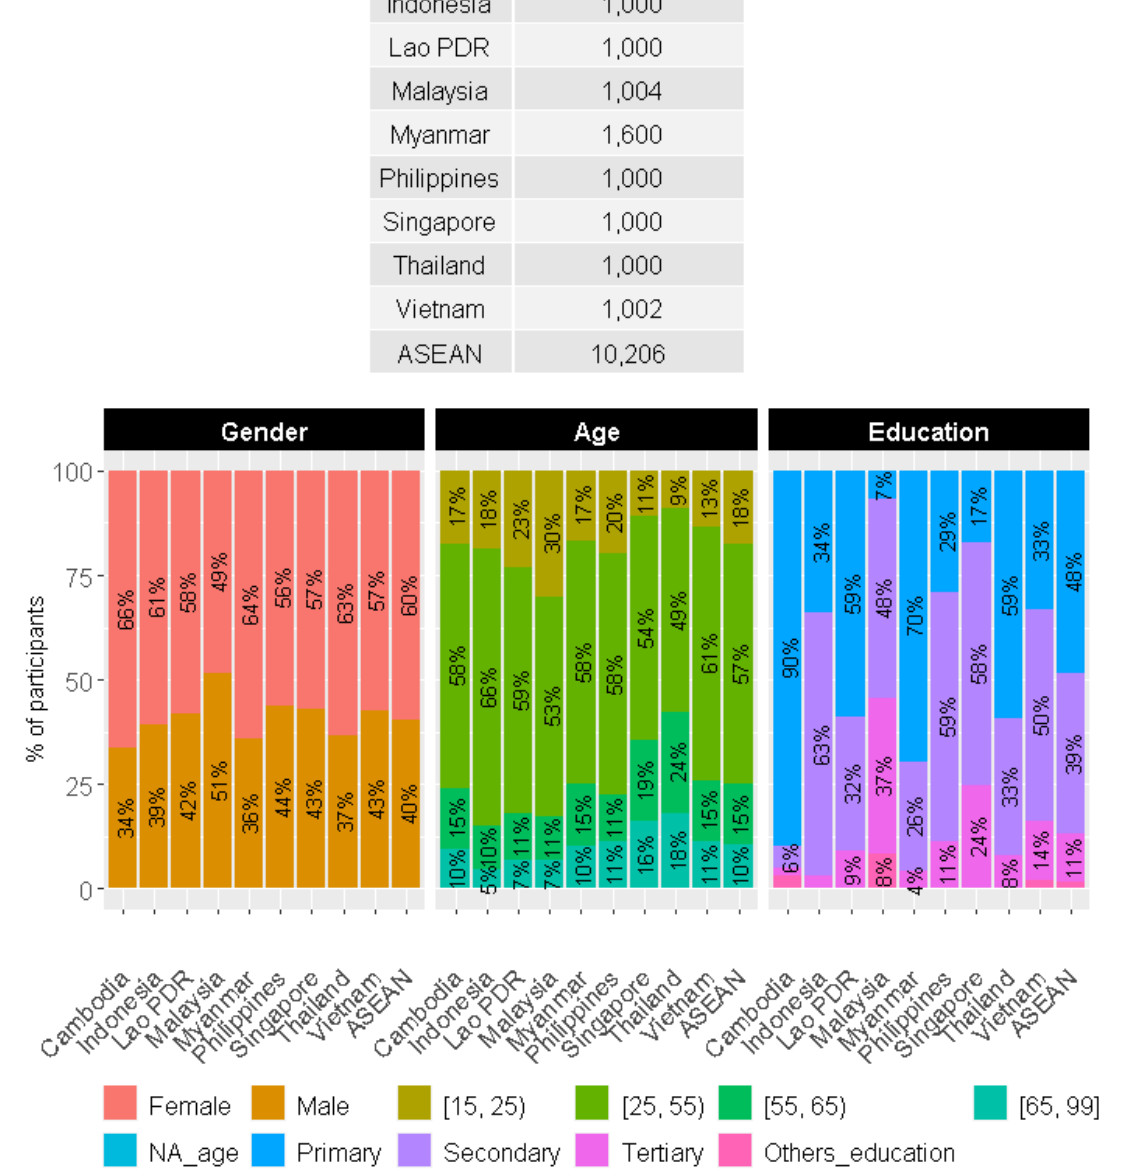
Figure 2. Demographic information of participants from ASEAN countries .